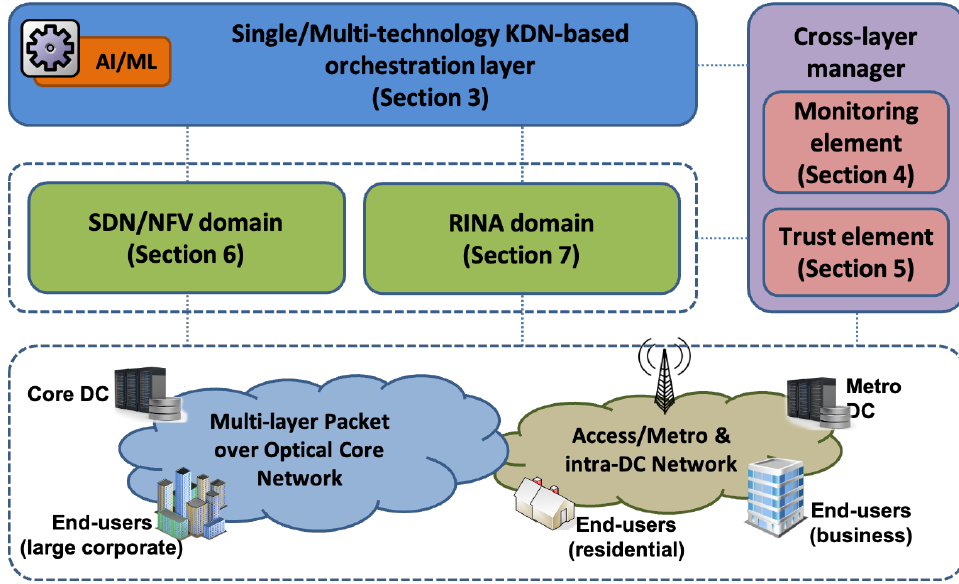
Figure 1. The ALLIANCE network